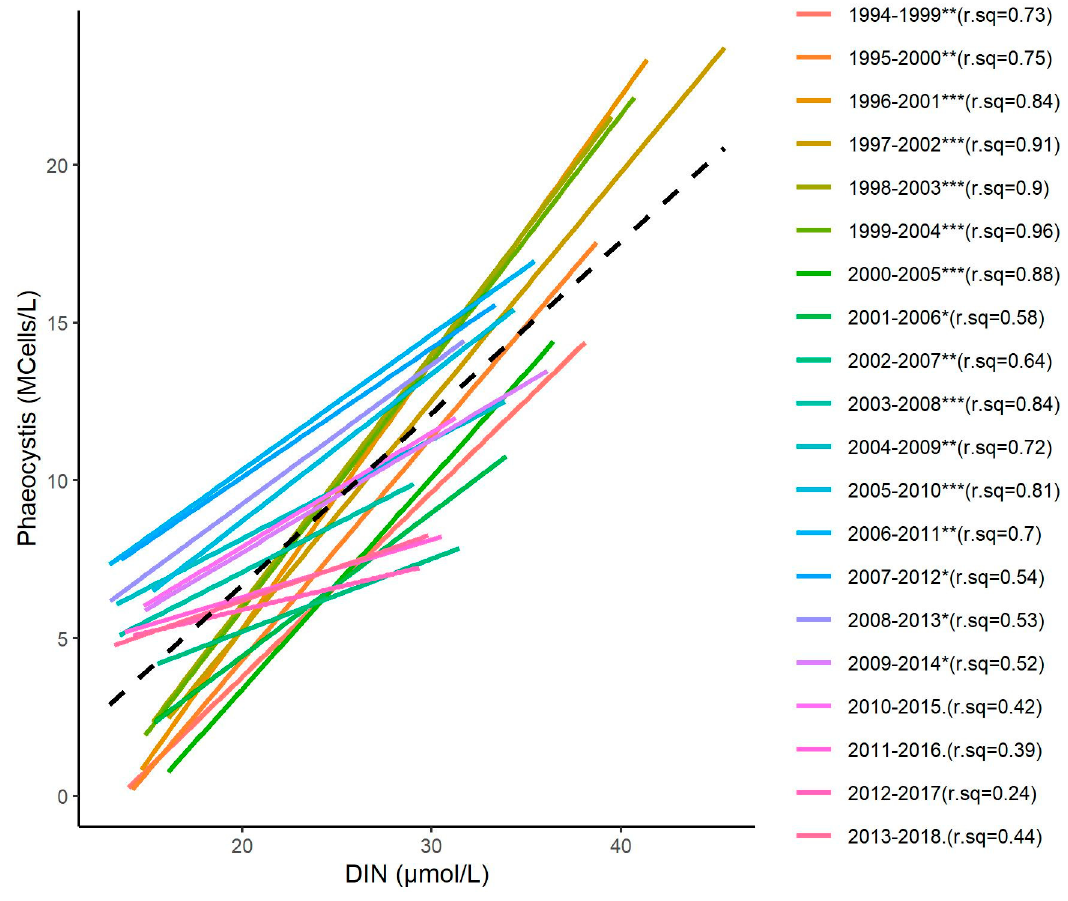
Figure 9. Linear regressions of the relationship between Phaeocystis and Dissolved Inorganic Nitrogen (DIN) concentrations by six-year sliding period. Input values for both variables are averaged maxima by period, calculated during the growing season for Phaeocystis and during the winter season for DIN. p -values as well as r-squared are indicated in the legend, next to each corresponding period (0 ‘***’ 0.001 ‘**’ 0.01 ‘*’ 0.05 ‘.’ 0.1 ‘ ’